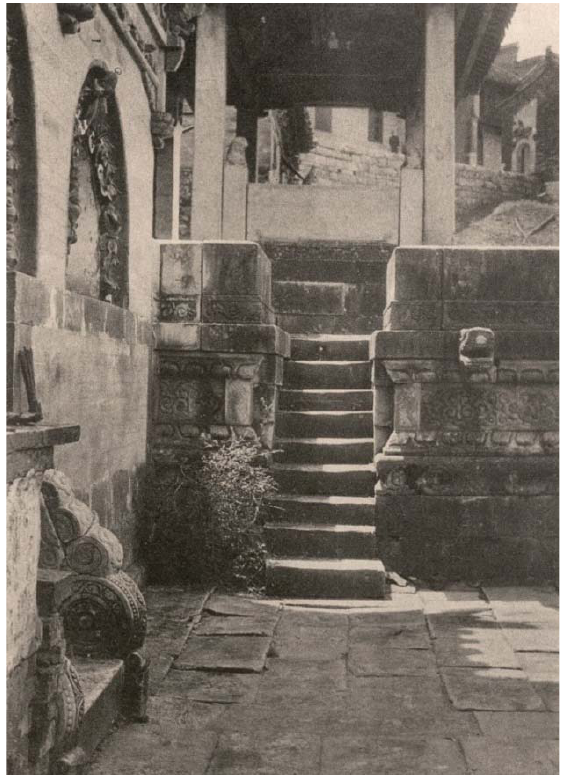
Figure 20. Viewing the Open ‐ Air Platform from the doorway of one of the Beamless Halls, showing the West Side Stair and part of the Stone Incense Pavilion (Prip ‐ Møller 1937, p. 249, Figure 276).